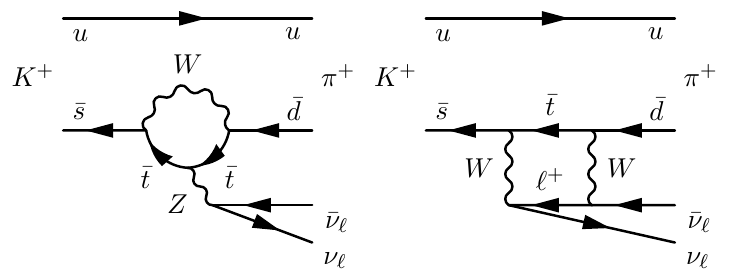
Figure 7 . Leading order SM contributions to the decay K + ! (cid:25) + (cid:23) (cid:22) (cid:23) .